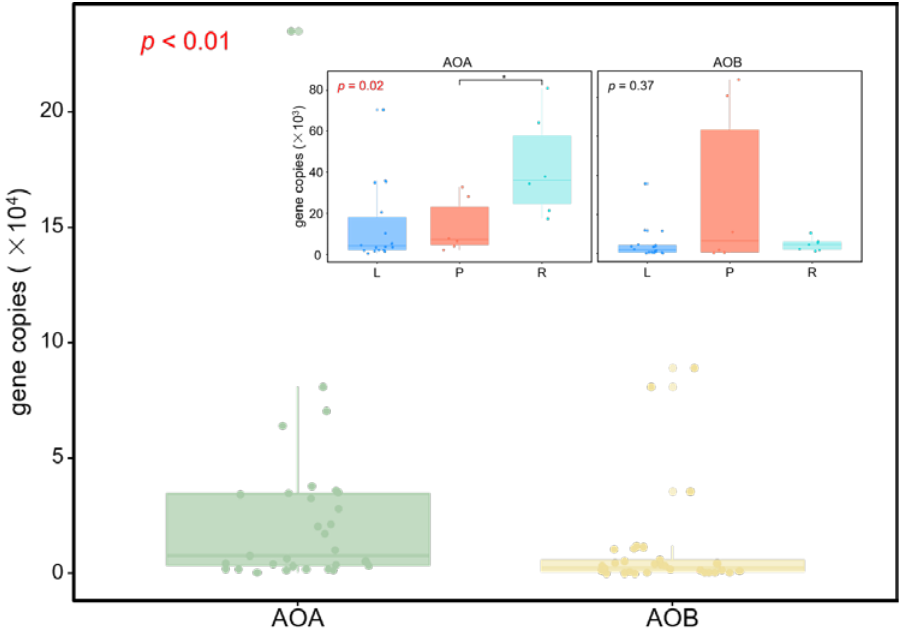
Figure 2. Abundance of ammonia-oxidizing microbe communities in soils. The graphs on the top right show the differences in abundances among lacustrine (L), palustrine (P), and riverine (R) wetlands. The asterisk indicates the statistical significance between two wetland types (* p < 0.05).